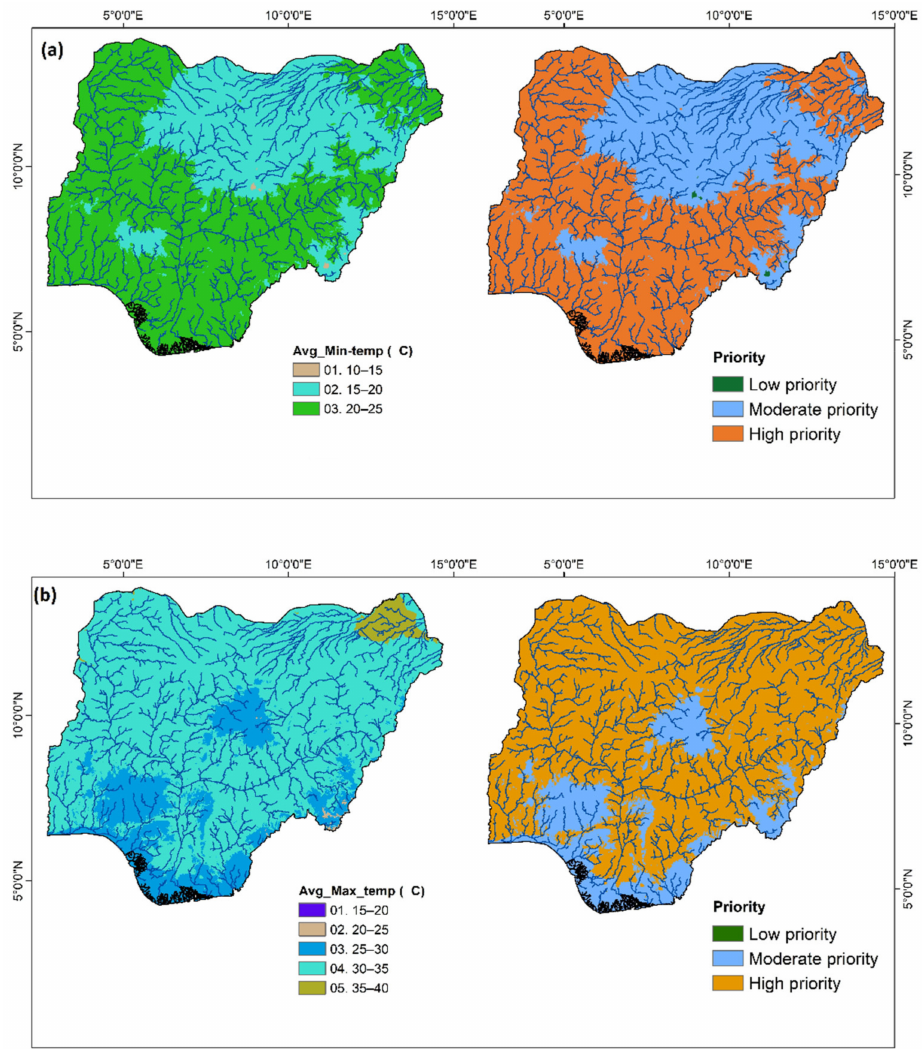
Figure 8. ( a ) Average annual minimum temperature and it priority map. ( b ) Average annual maximum temperature and its priority